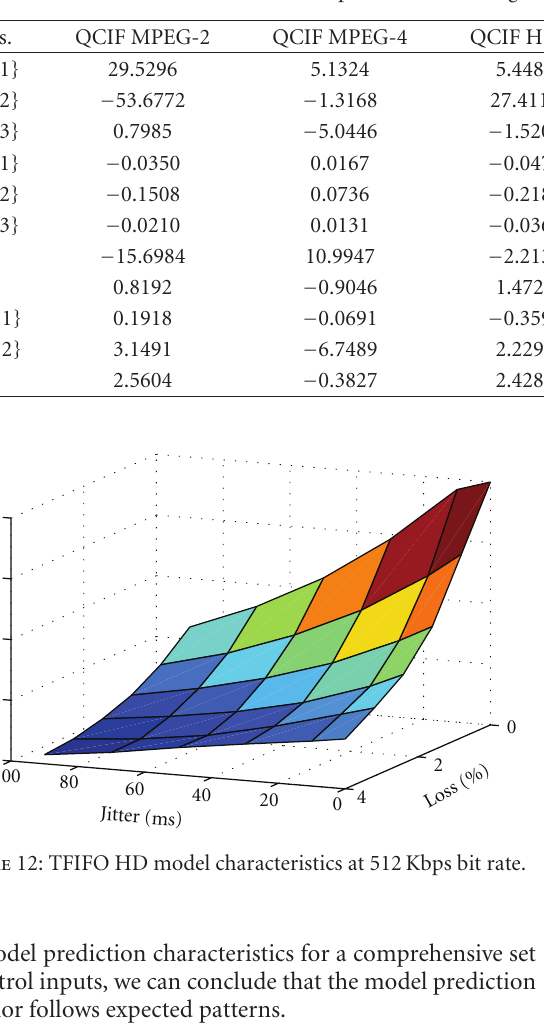
Table 8: PFIFO model parameters showing weights and biases for QCIF and QVGA resolutions.